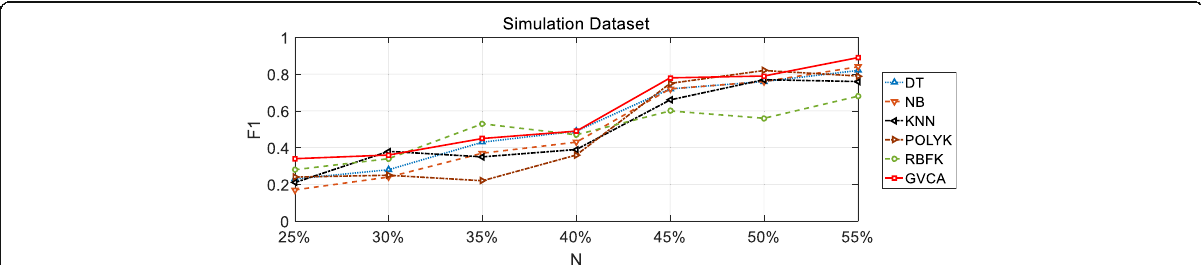
Fig. 1 Comparison of the convergence rate of simulation dataset by the GVCA method and other classification algorithms